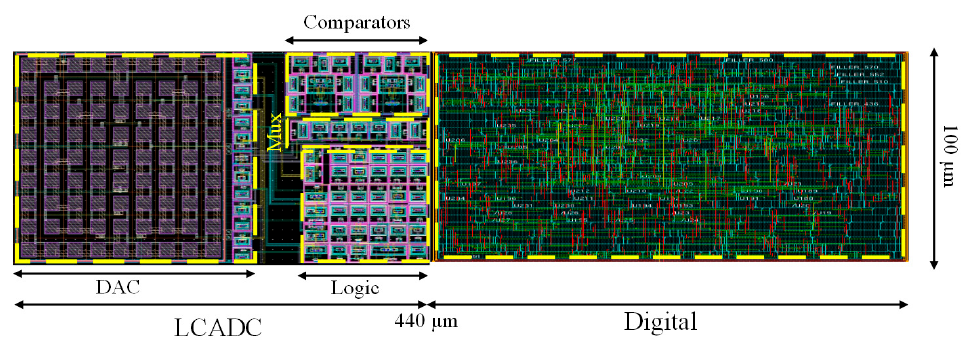
Figure 15. Layout of the proposed VAD system. Table 2. Power consumption of different sub-blocks of proposed VAD system and total VAD power used for audio signal corrupted with 10 dB white noise.